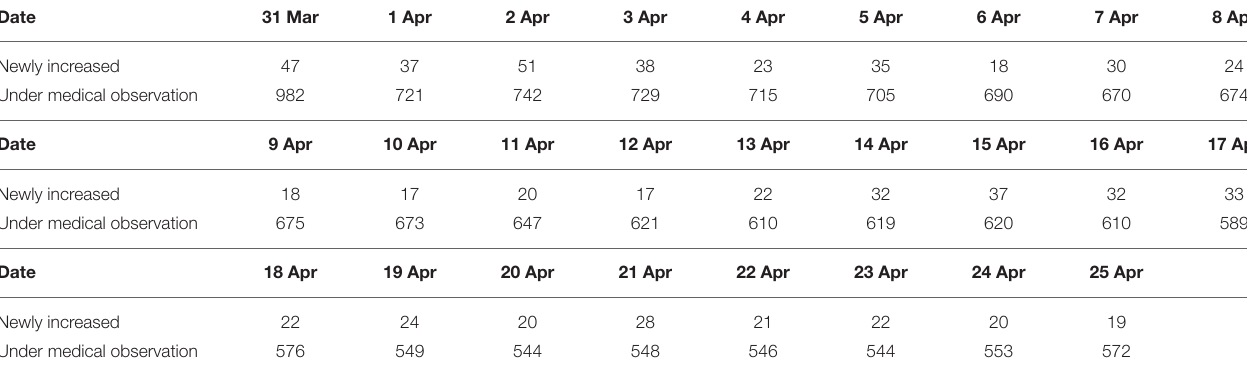
TABLE 1 | Situation of asymptomatic COVID-19 infection in Hubei Province by the end of the